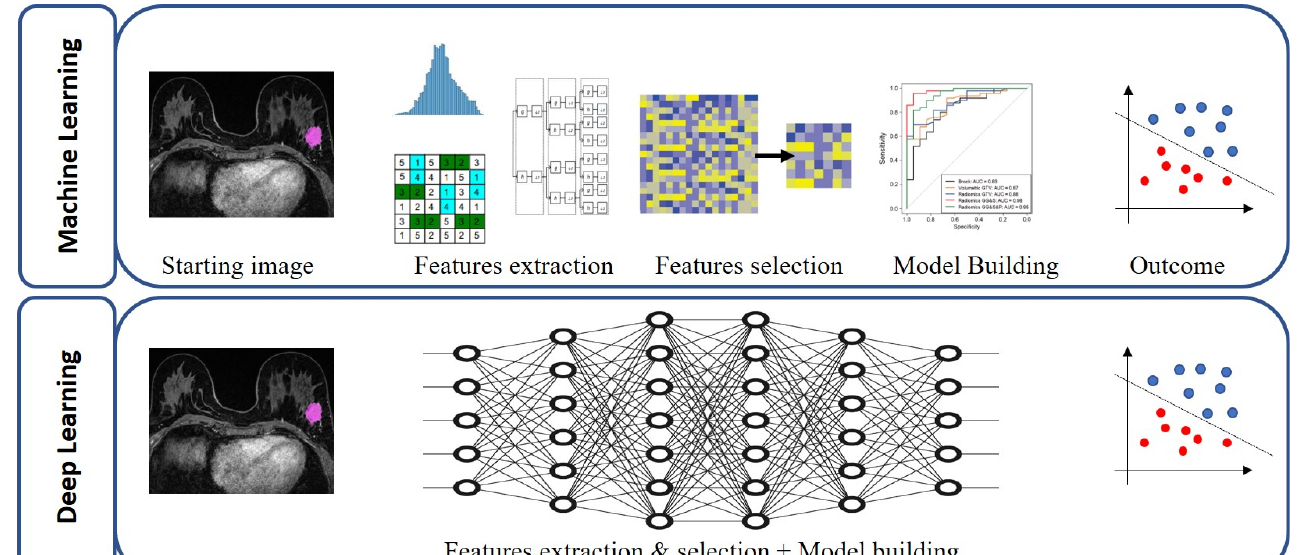
Figure 5. Difference between machine learning (ML) approach and deep learning (DL) approach, in which the steps of feature extraction, selection and classification are performed as a unique task.